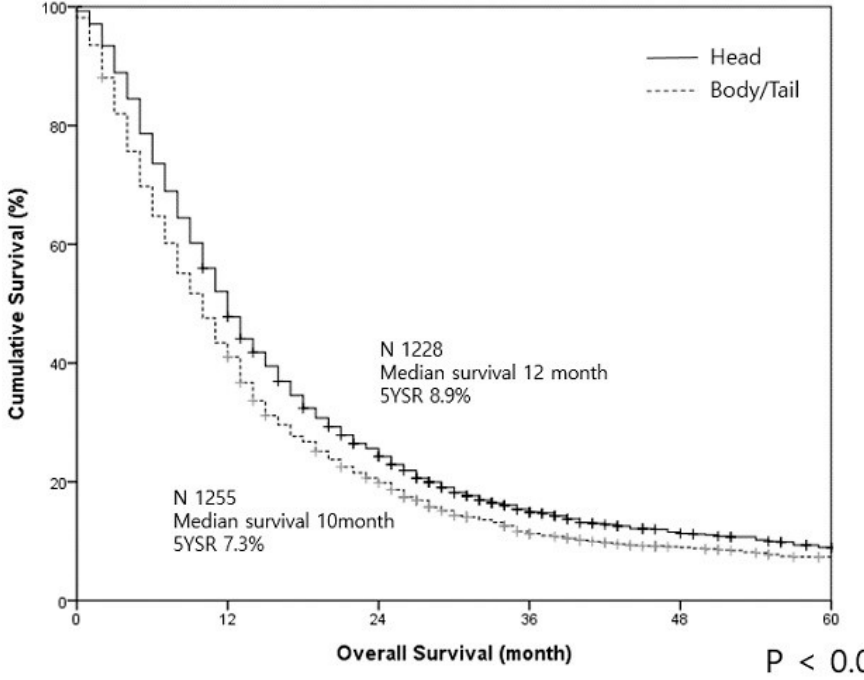
Figure 1. The survival curves of pancreatic cancer in the head / uncinate region and body / tail regions in all patients are illustrated.